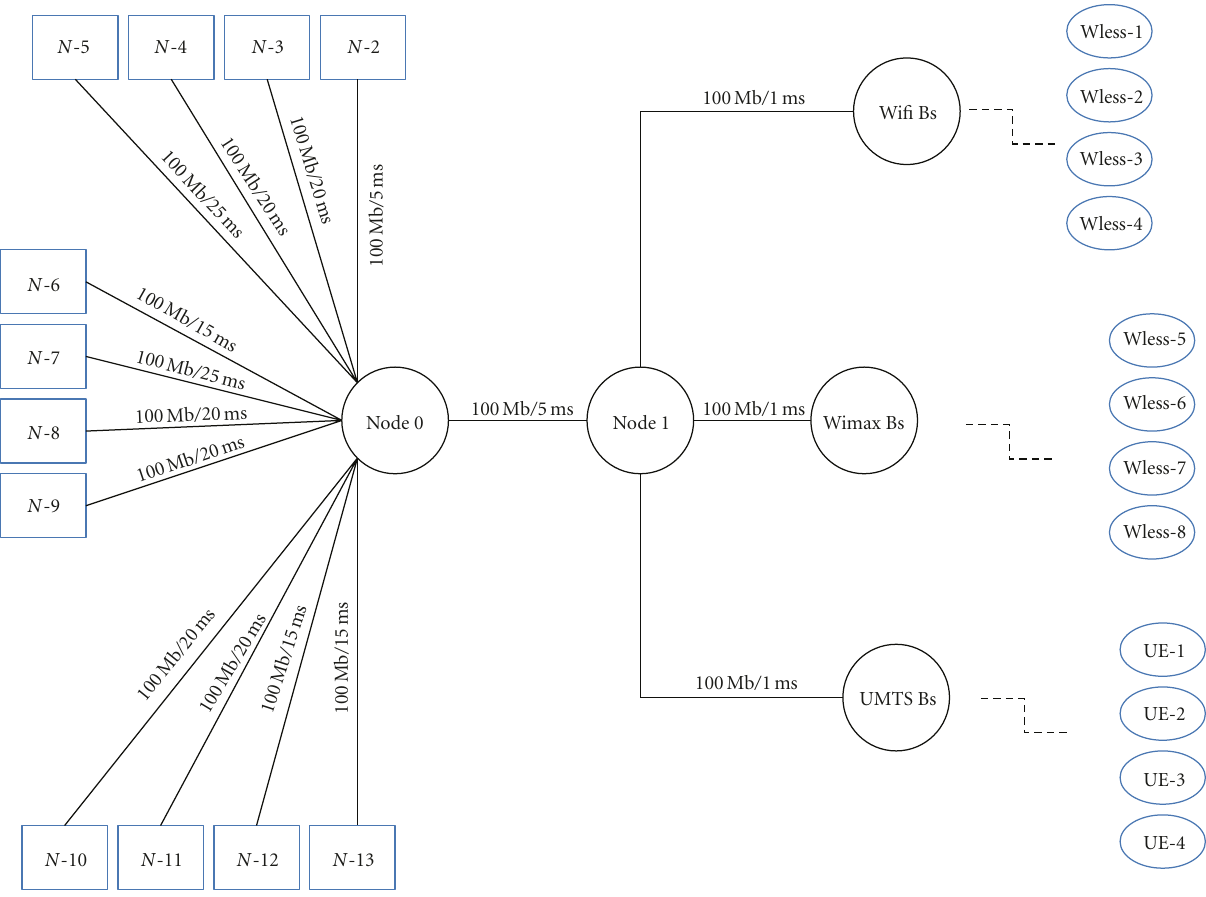
Figure 9: Network topology for performance